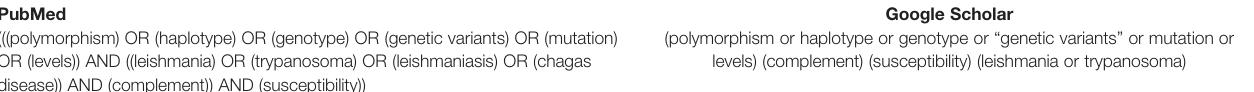
Genetic variants were associated with CL patients; Expression levels vary among the genetic variants.